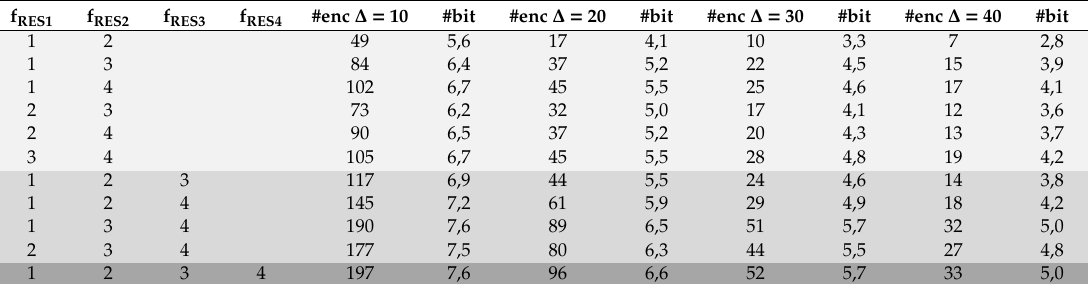
Table 3. Number of available encoded states and bits for di ff erent combination of resonance frequencies and values of ∆ , the error expressed in MHz.